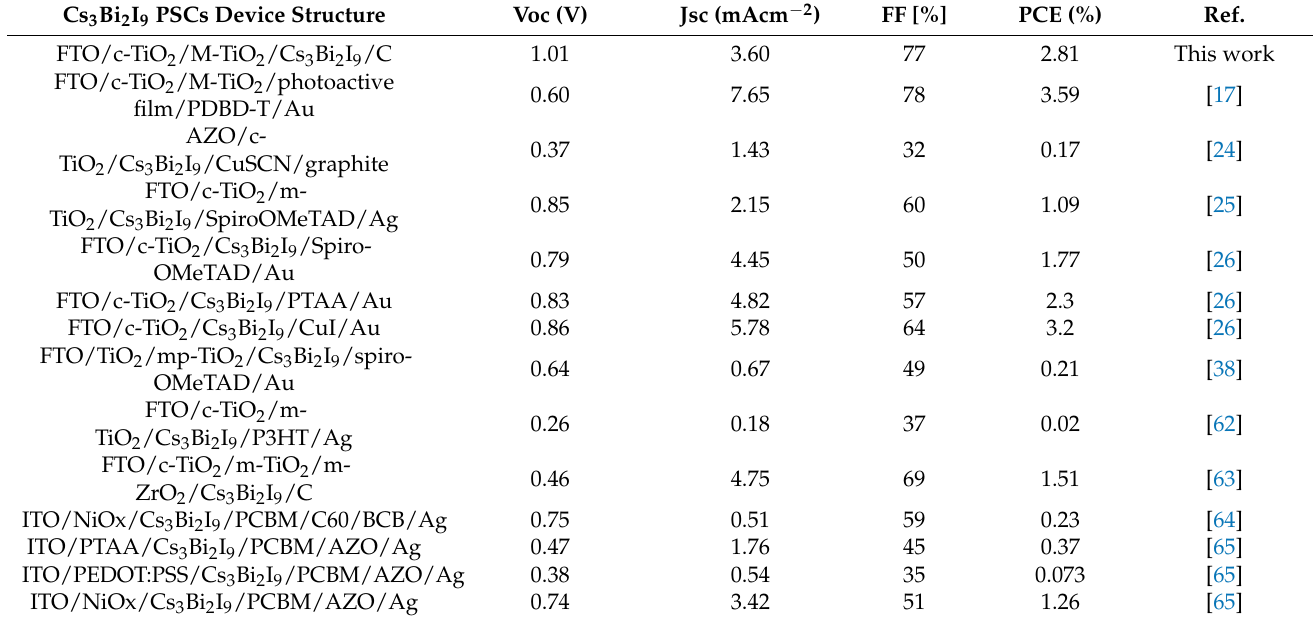
Table 2. Published photovoltaic performances of lead-free bismuth-based (Cs 3 Bi 2 I 9 ) PSCs fabricated to date.